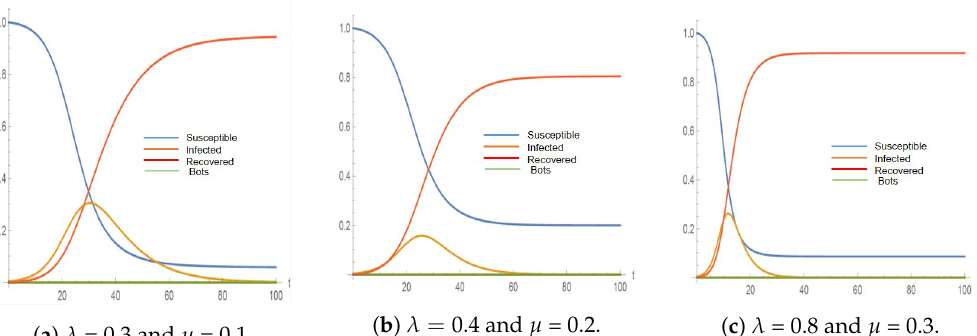
Figure 2. The simulation results for SIR model using different rates on the 2012 dataset (a is the best fit).